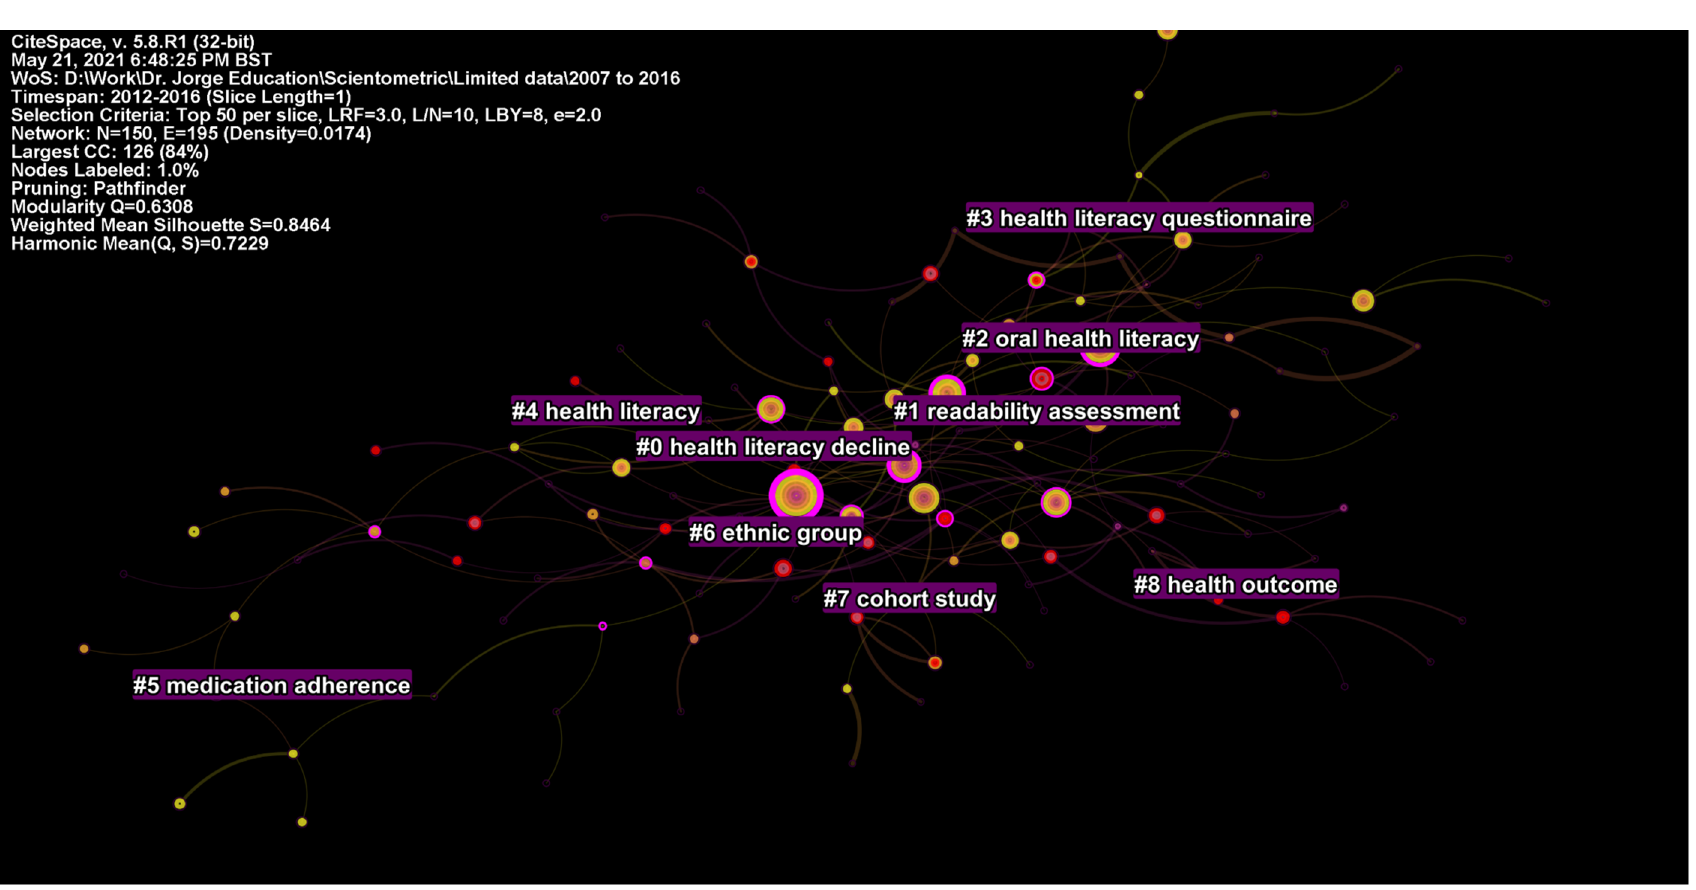
Figure 7. Top clusters of research published from 2012 to 2016.